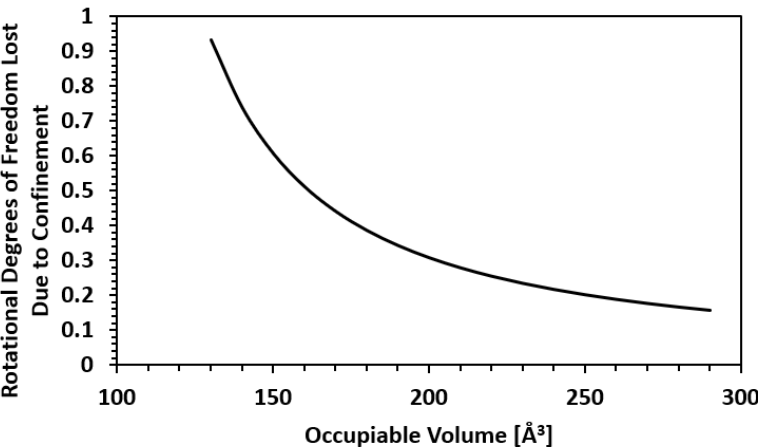
Figure 4. Calculated rotational degrees of freedom lost upon adsorption with varying occupiable volume (V occ ).